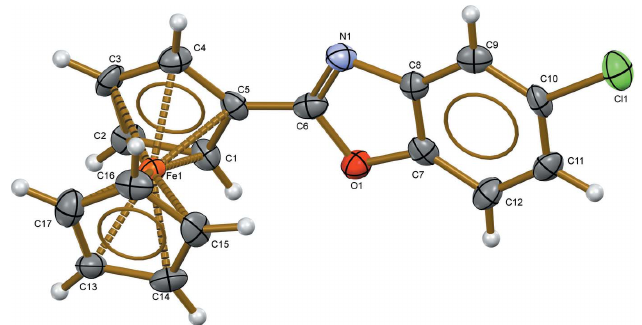
Figure 1 The molecular structure of the title compound, showing the atom labelling. Displacement ellipsoids are drawn at the 60% probability